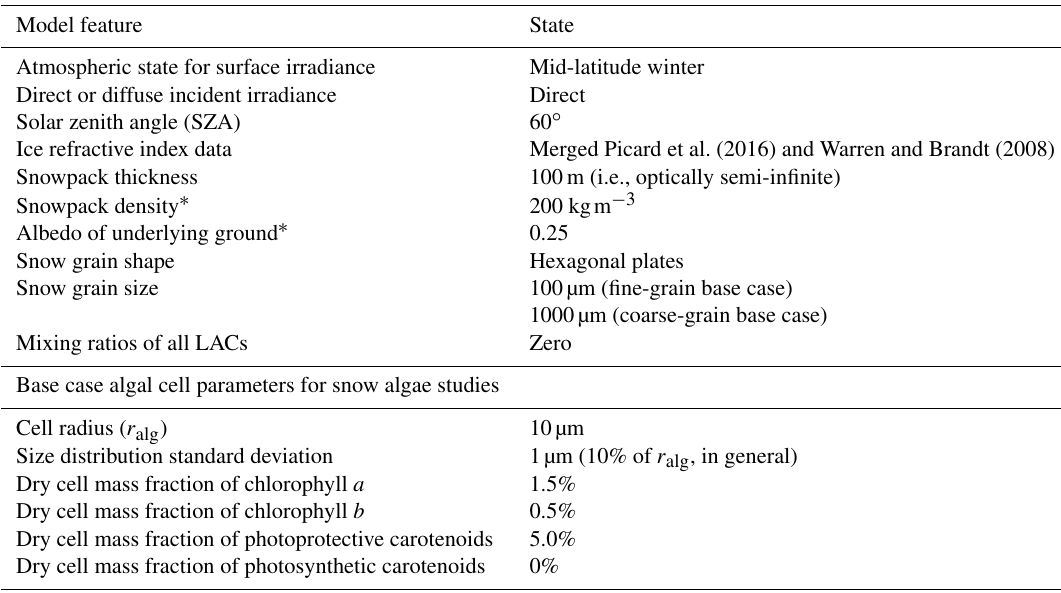
Table 3. Model base case parameters for sensitivity studies and default parameters for the web-based